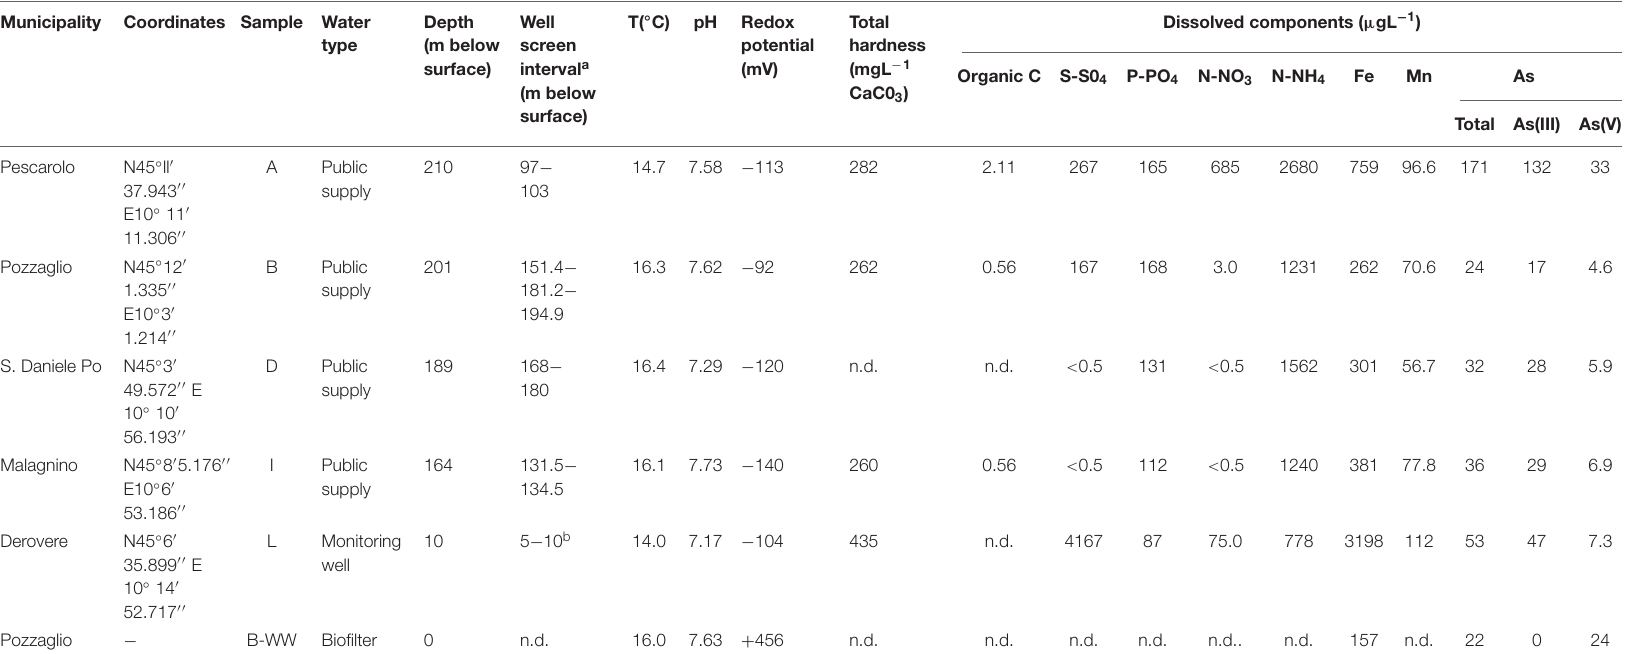
Pozzaglio − B-WW Biofilter